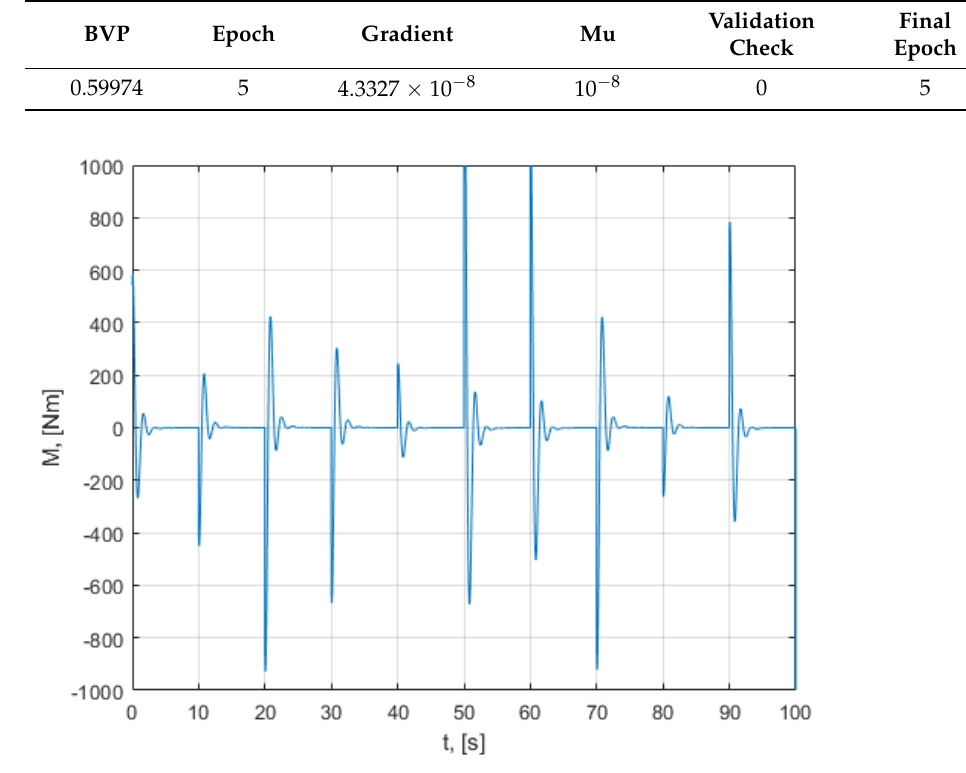
Figure 46. Torque. Figure 46.